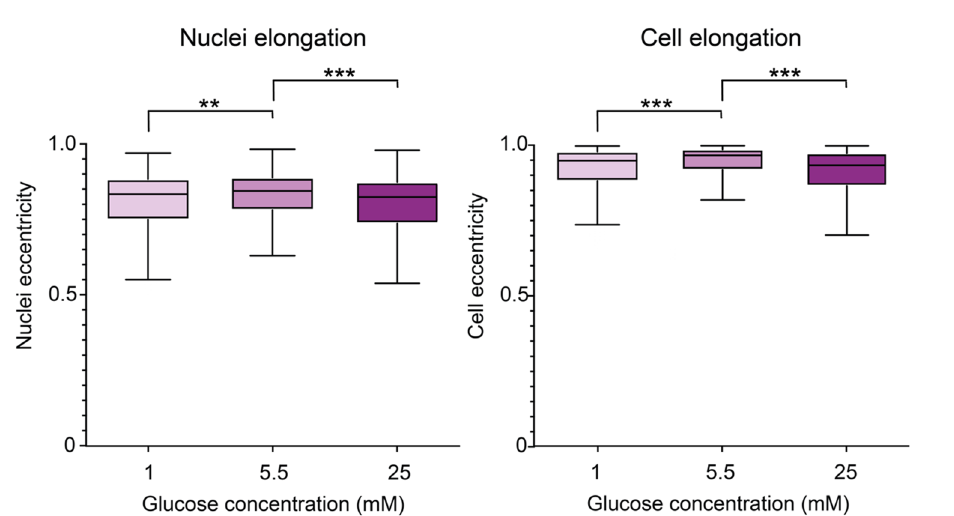
Figure 6. Nuclei and cell elongation of brain microvascular endothelial cells is affected by glucose levels. Box plots of nuclei and cell elongation dependent on the different glucose conditions low (1 mM), normal (5.5 mM), and high (25 mM), where 0 denotes a round structure and 1 a line. For the statistical analysis 750 nuclei and cells were used for each condition. The statistics included in figure 6 are summarized in Supplementary Tables S9, S10, and *denotes p ≤ 0.05, **denotes p ≤ 0.01, and ***denotes p ≤